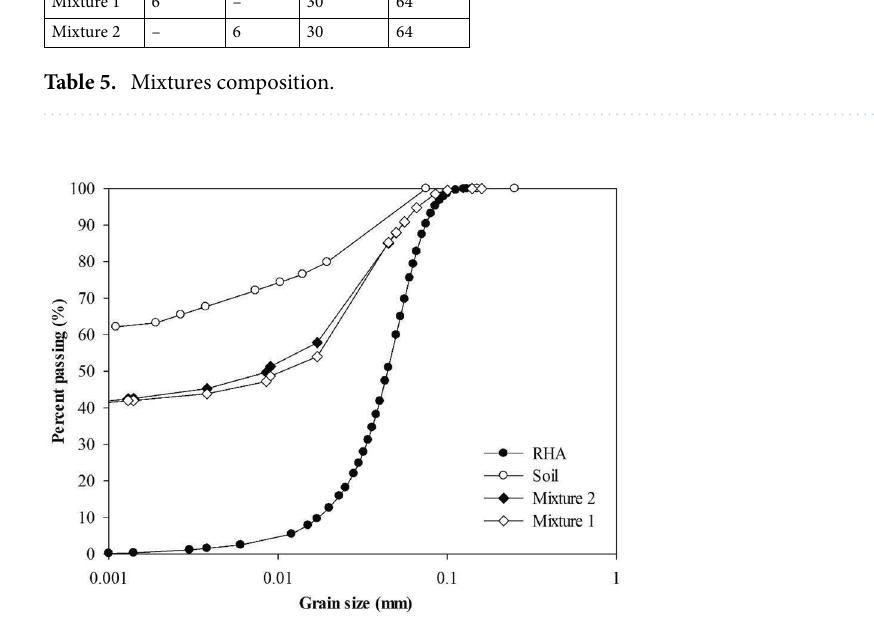
Figure 4. Particle size distribution of mixtures, compared to soil and